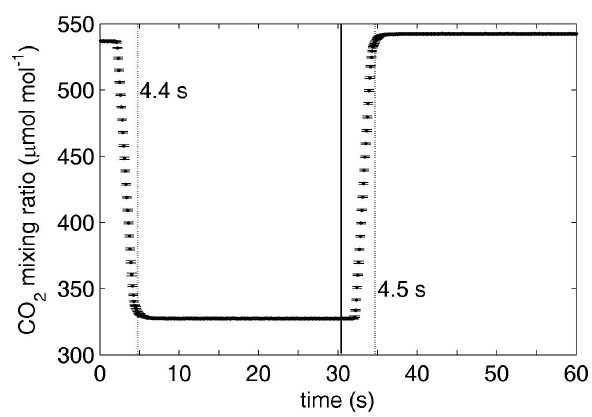
Fig. 2. Average 12 C 16 O 2 mixing ratios ( ± 1 standard deviation) measured during switching between secondary calibration stan- dards at 10Hz ( n = 44). The solid horizontal lines indicate the times (0 and 30s) when the TGA sampling system switched from low (327µmolmol − 1 ) to high ( ∼ 543µmolmol − 1 ) concentration cali- bration tanks, and dotted lines indicate the times (4.4 and 4.5s) af- ter switching air intakes at which TGA readings reached 95% of the total